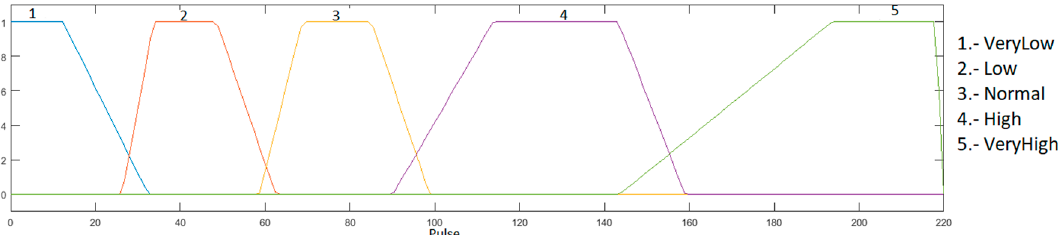
Figure 19. Optimized input age.